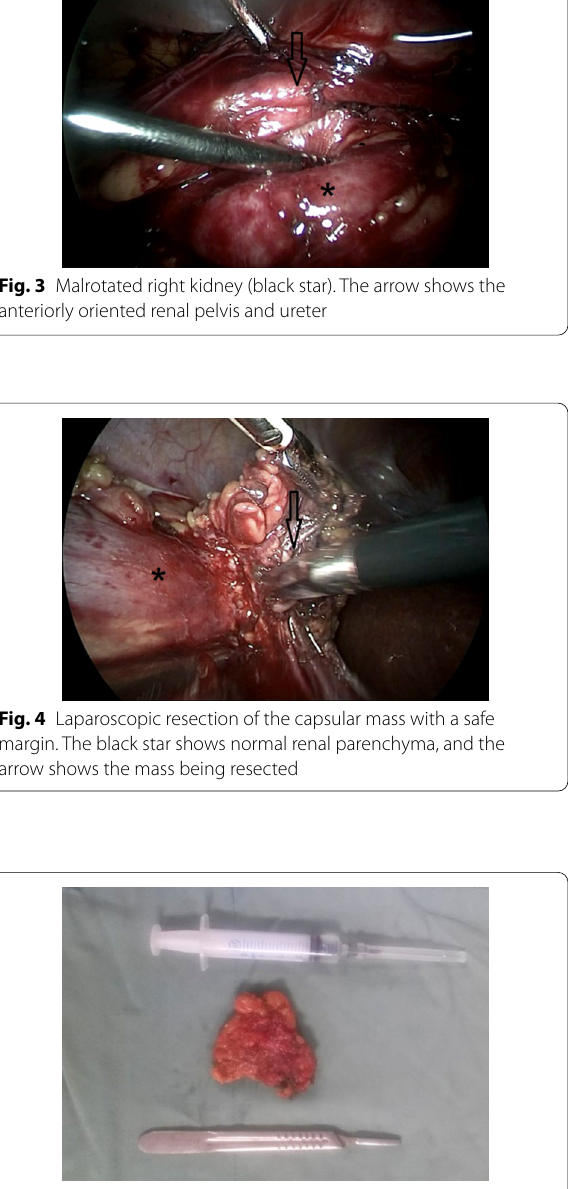
Fig. 5 Macroscopic (gross) view of the capsular mass